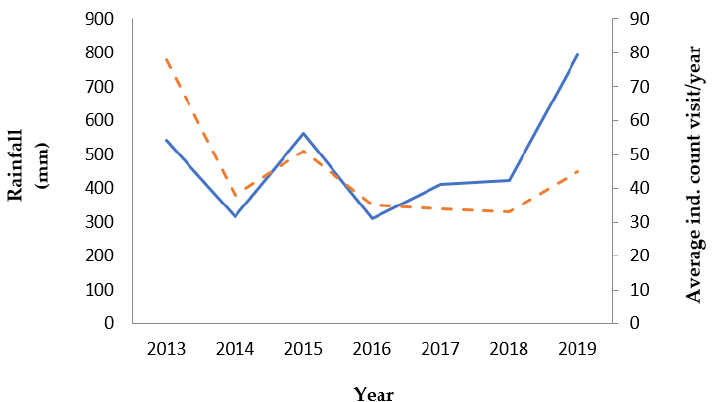
Figure 4. Relation between annual rainfall (continuous blue line) and the mean adult count per visit per year (dotted line in red). Table 3. Average annual rainfall levels for the four 30-year periods since